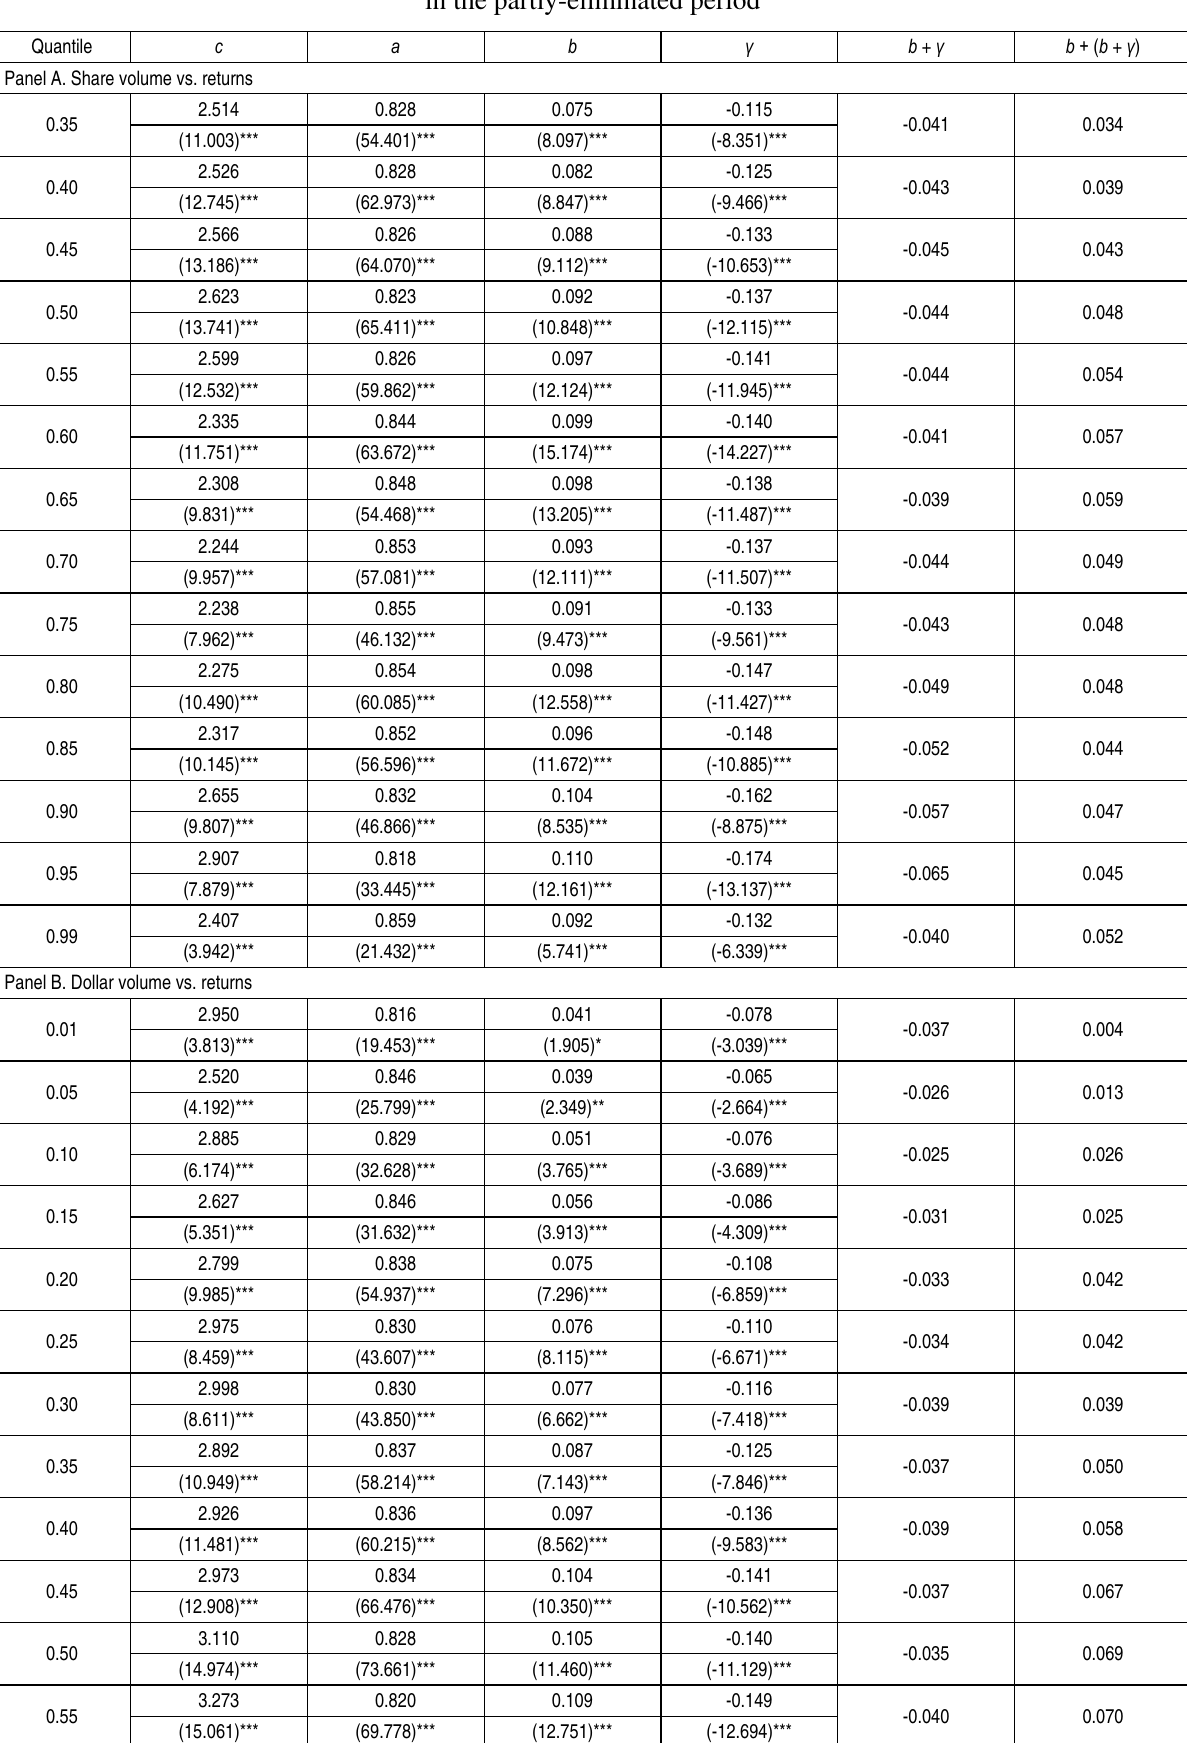
Table 7 (cont.). Quantile regression estimates of volume-signed return correlation for TAIEX in the partly-eliminated